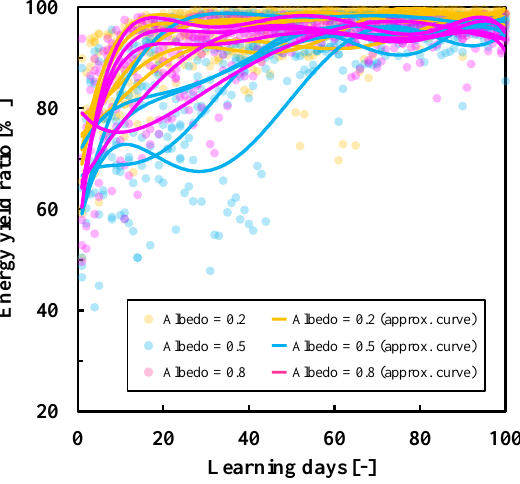
Figure 6. Variation of daily energy-yield ratio of AI control ( R AI ) over 100 learning days from the start of the 5-year simulation (RUNs 1 – 5).